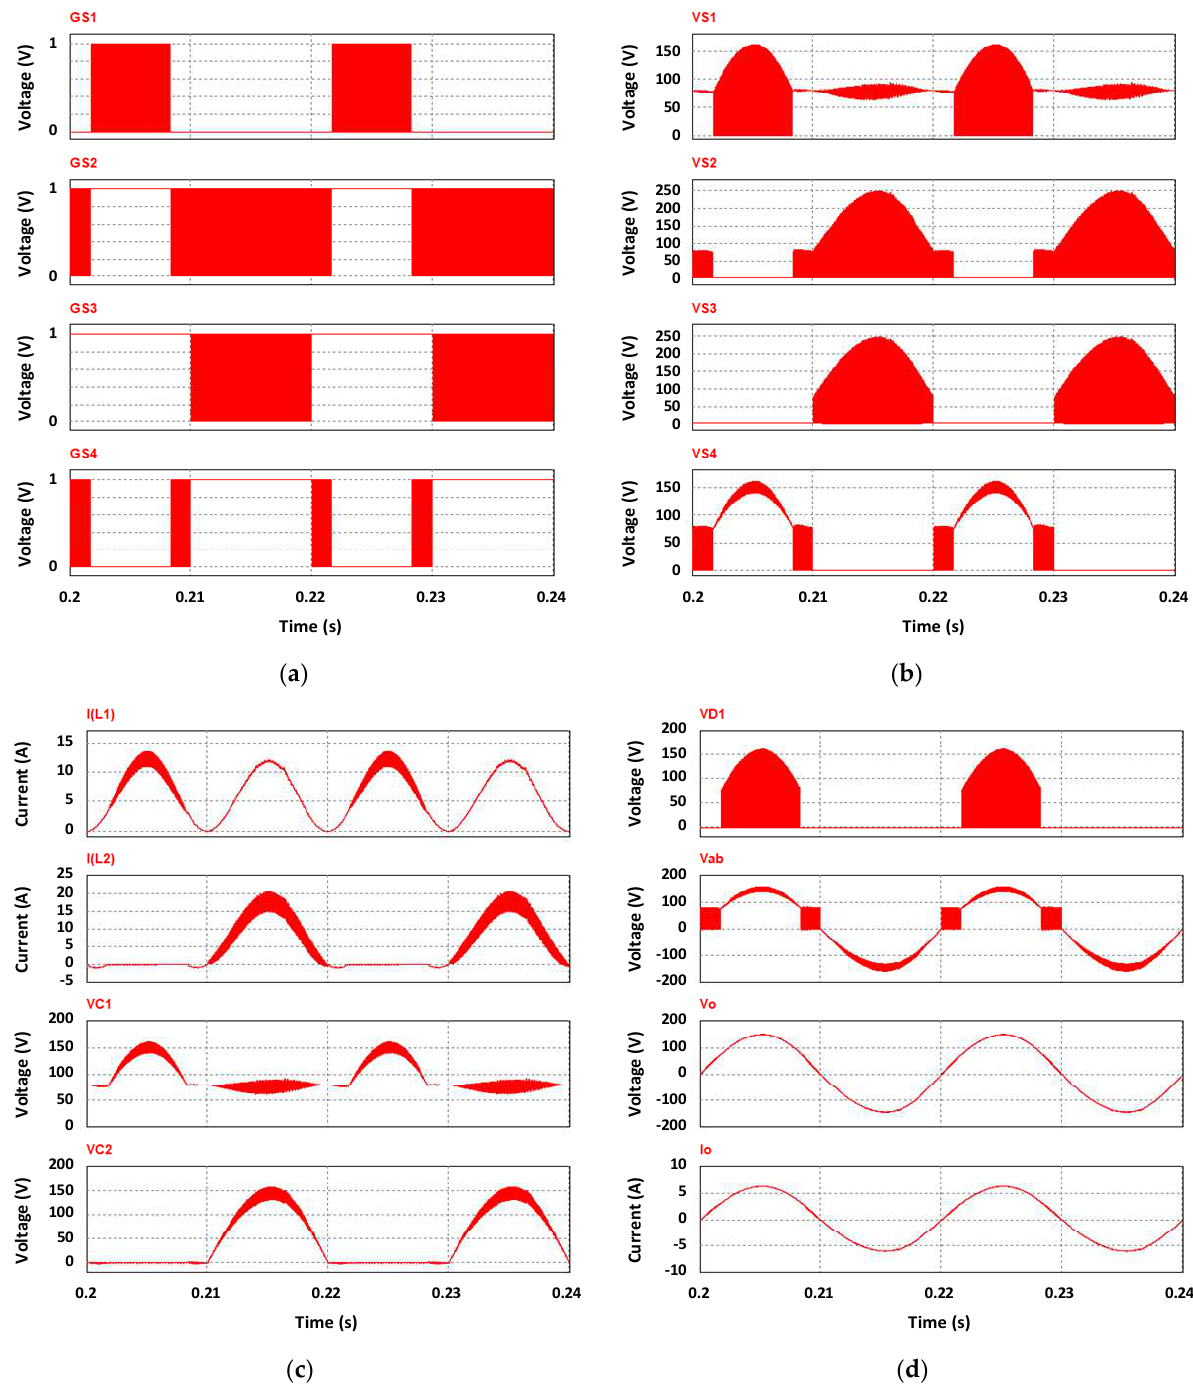
Figure 5. Simulation results for the proposed single-stage BB-BTI when V in = 80 V. ( a ) Control signals of S 1 , S 2 , S 3 , and S 4 . ( b ) Voltages V S 1 , V S 2 , V S 3 , and V S 4 . ( c ) currents i L 1 , i L 2 , and voltages v C 1 , v C 2 . ( d ) Voltages V D 1 , v ab , and v o , and current i o .